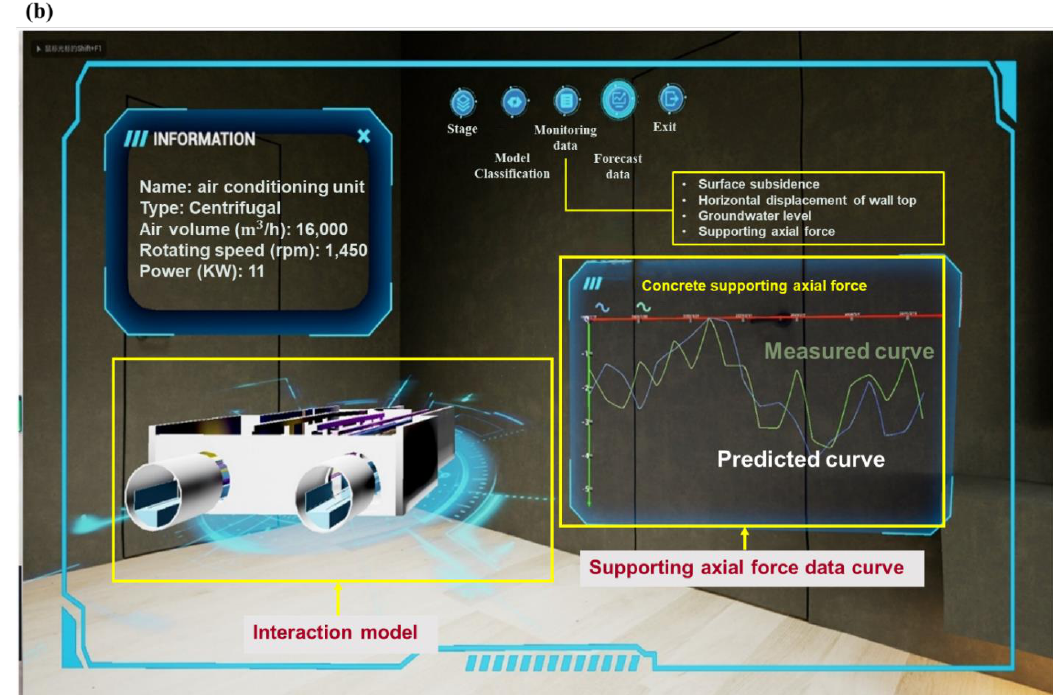
Figure 11. ( a ) Monitoring data of supporting axial force. ( b ) Predicted data of support axial force monitoring point.